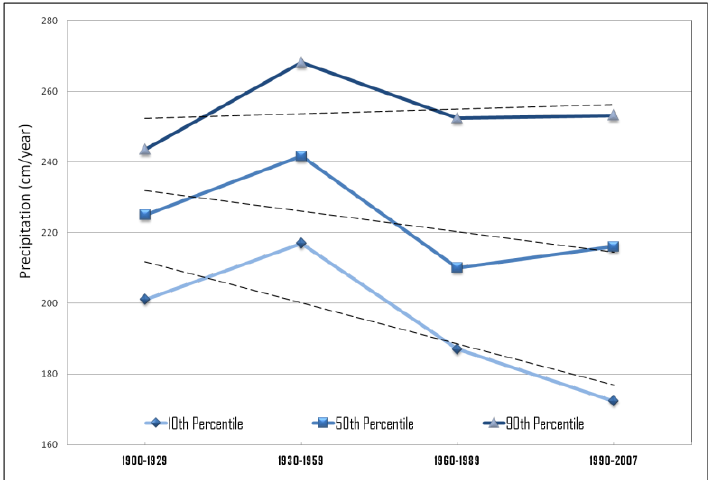
Figure 19. Annual precipitation quantiles for wet forest by period.